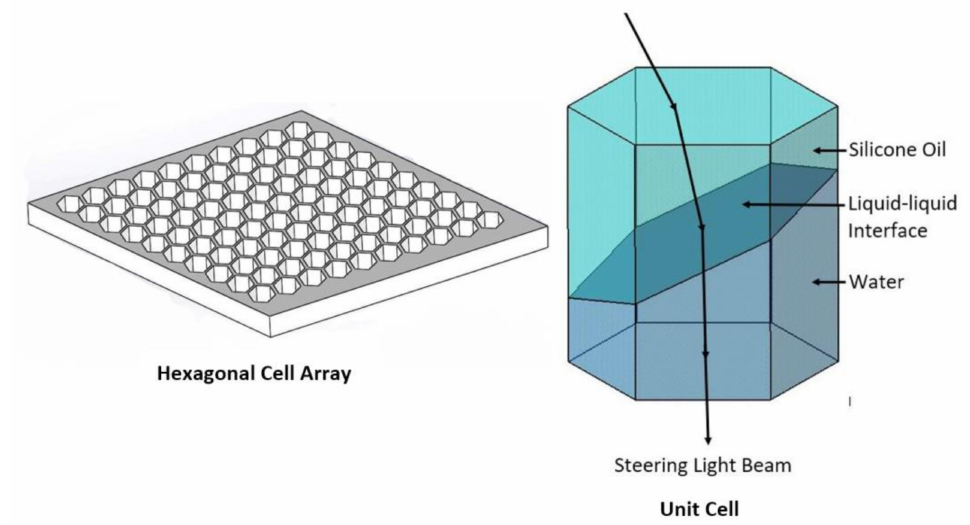
Figure 3. Proposed design of the electrowetting solar energy tracking and concentration